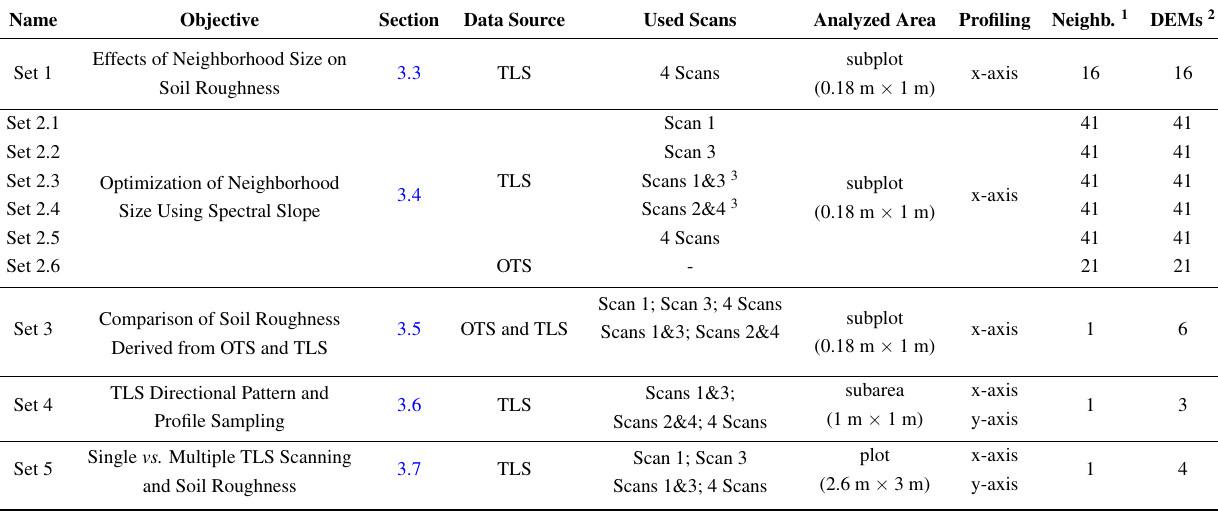
Table 2. The overview of the DEM sets used for the